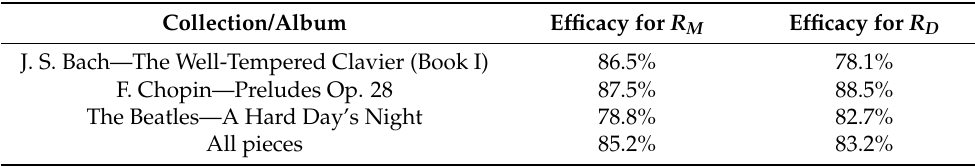
Table 2. Overall * efficacies of the key detection obtained using the signature of fifths for different weighted pitch-class representations of analyzed fragments of music, where R M —the multiplicities of occurrences of individual pitch-classes; R D —the aggregate durations of individual pitch-classes.